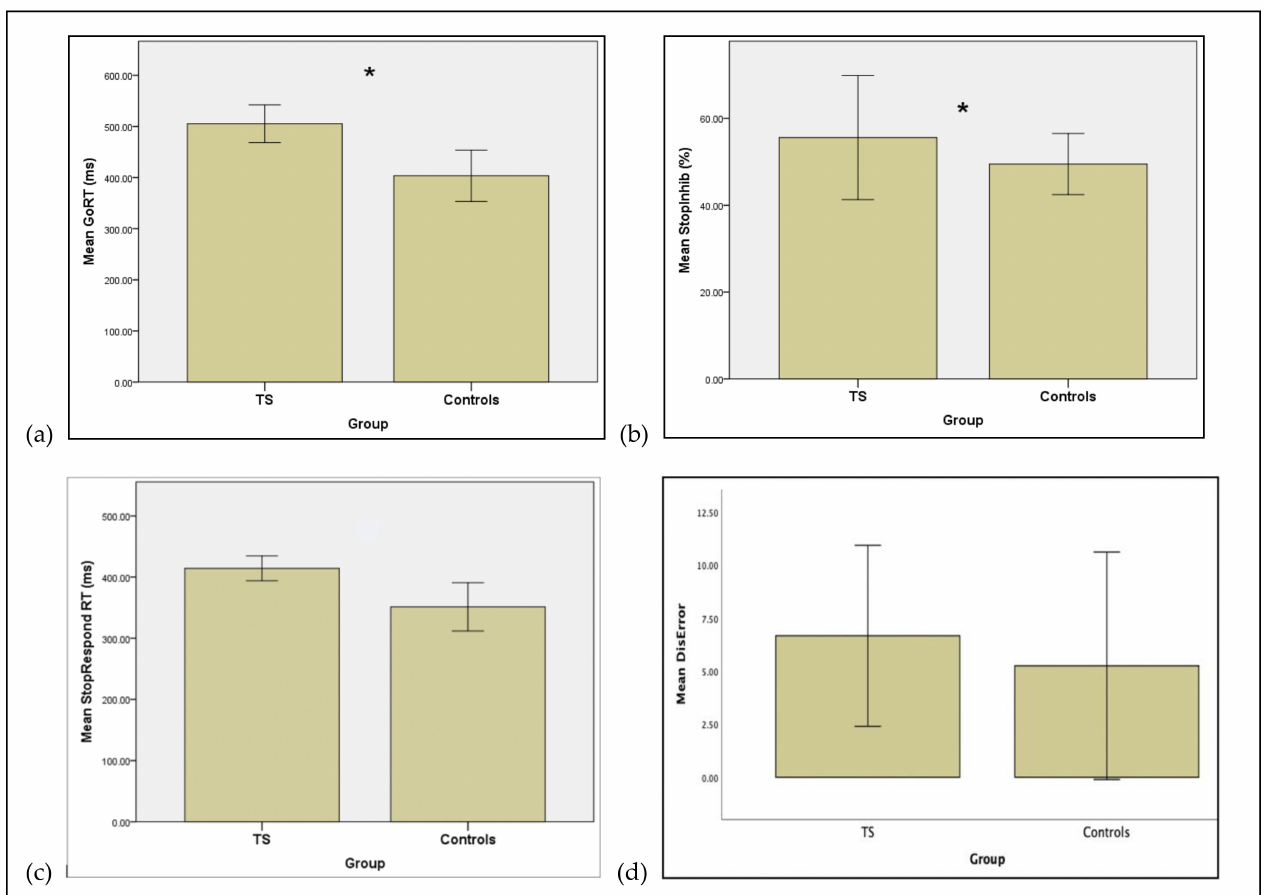
Figure 1. Mean measures for patients with Tourette syndrome (TS) before deep brain stimulation surgery and healthy controls. ( a ) Mean GoRT (ms) ( b ) Mean Stop Signal Delay (SSD, ms) ( c ) Mean StopRespond RT (StopRespond RT, ms). ( d ) Mean number of Discrimination Errors (Discrimination Error). Error bars represent standard errors of the mean. * Significant difference p <